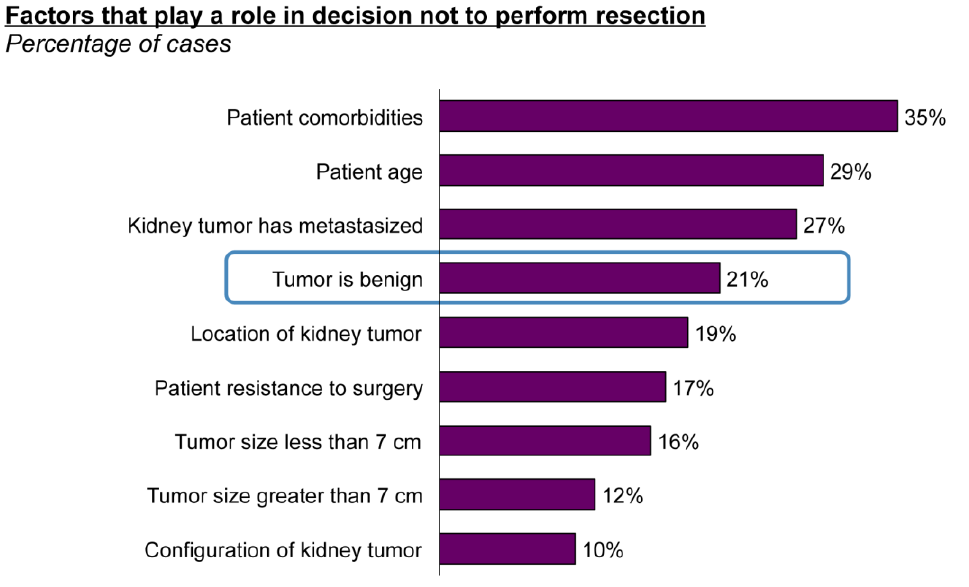
Figure 5. Factors influencing decisions not to resect kidney tumors.